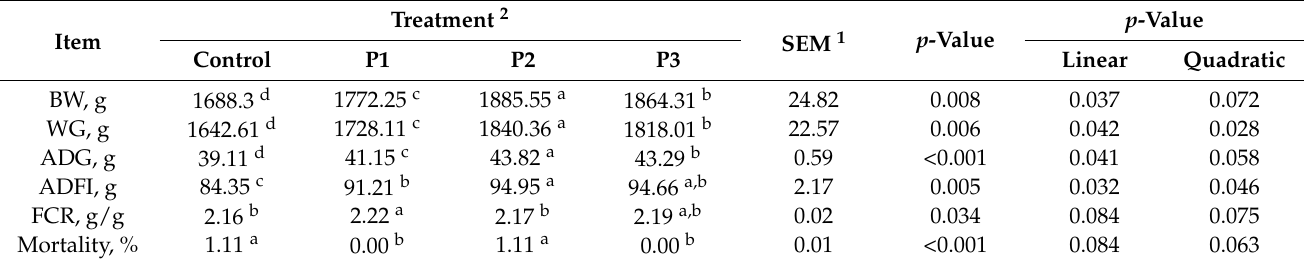
Table 3. Effect of dietary supplementation with dried jujube powder on growth performance of broilers.